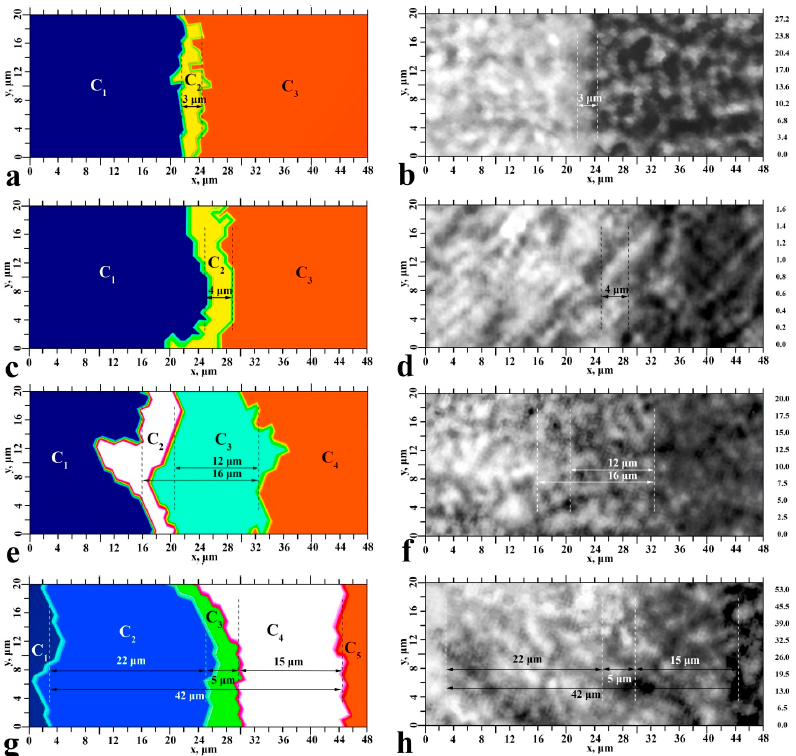
Figure 6. Results of the cluster analysis for the studied samples ( left ) and optical images of ×100 sections in the interface region ( right ). Sample S I —( a , b ); sample S II —( c , d ); sample S III —( e , f ); sample S IV —( g , h